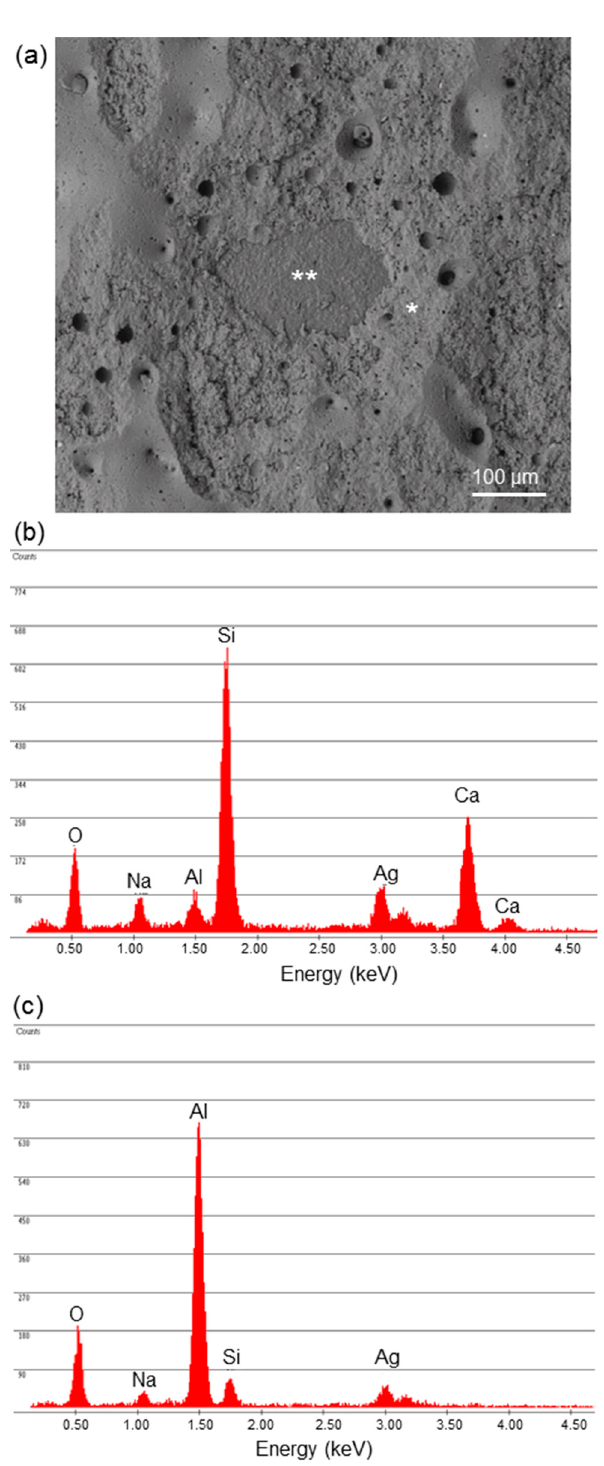
Figure 5. Analysis of fracture surface: ( a ) SEM micrograph showing the morphology of the coating after tensile test and ( b , c ) compositional assessment to identify the areas of adhesive and cohesive fracture. The region marked with (*) in ( a ) corresponds to the fracture area inside the coating (the corresponding EDS pattern in ( b ) reveals the presence of all the typical elements of the glass composition, i.e., Si, Ca, Na, and Al), while the region marked with (**) corresponds to interfacial delamination (a high peak for Al is visible in the corresponding EDS pattern in ( c ), with just small traces of Si and Na).